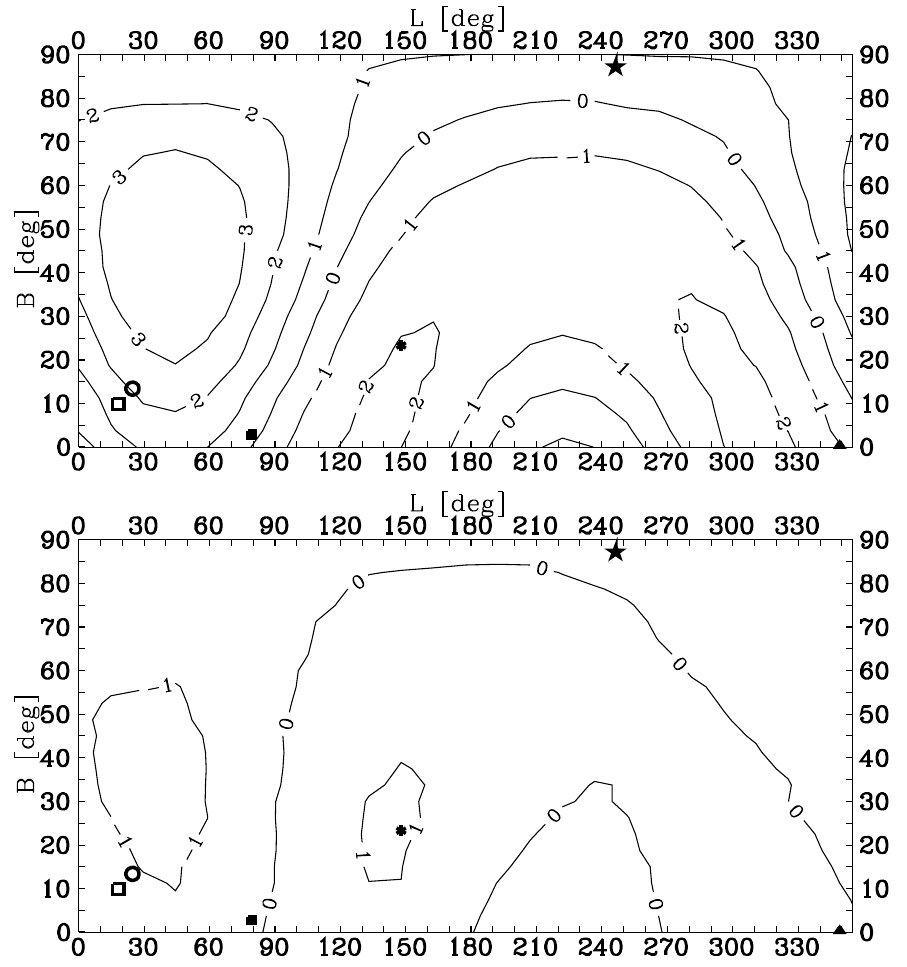
∆ ∆ Figure 12. Maps of s 11 / σ ( 11 ) versus the chosen cluster pole supergalactic co-ordinates ( L , B ) for ≡ the Cluster 15, with results obtained with help of HHD and FP corrections. The maps are presented for all cluster galaxies (upper), as well as for spiral (middle) and non-spiral (bottom) sub-samples. In the map, we indicate the important directions, as seen from the center of the considered cluster: (1.) three cluster poles (full star, square and triangle), (2.) the direction to the Local Supercluster center (open circle), (3.) the direction of the Virgo A cluster center (open square) and (4.) the line of sight from the Earth